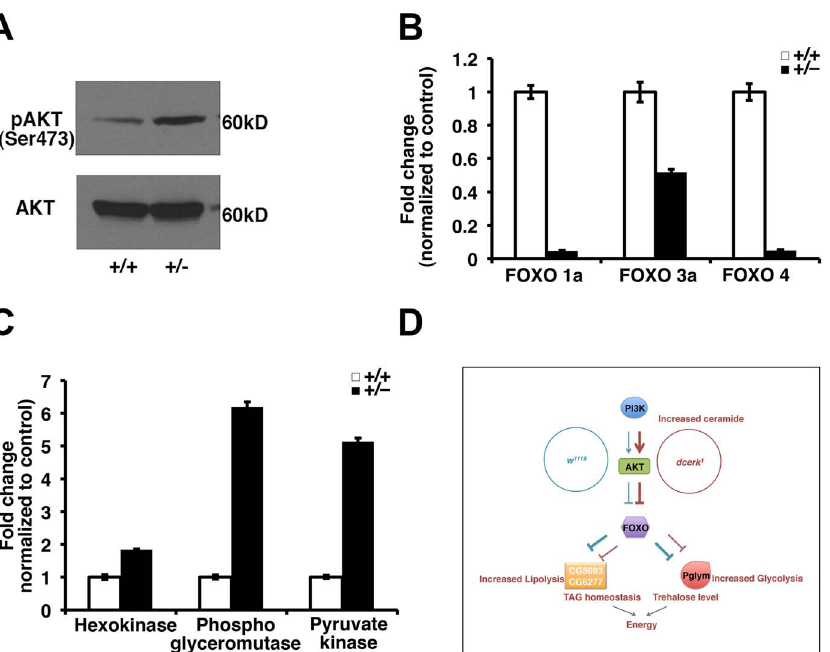
Figure 7. Activation of AKT, decrease in FOXO and activation of glycolytic genes in CERT heterozygous mice. (A). Total AKT and phosphoAKT levels are monitored in liver extracts from wild type ( + / + ) and CERT heterozygous ( + / 2 ) mice. PhosphoAKT level is increased in CERT heterozygotes while total AKT is not significantly changed. (B). Comparison of different FOXO in liver tissue of wild type ( + / + ) and CERT heterozygous ( + / 2 ) mice shows significant decrease in their transcript levels. (C). Comparison of glycolytic genes in skeletal muscle from wild type ( + / + ) and CERT heterozygous ( + / 2 ) mice shows greater than 5 fold increase in transcript levels of phosphoglycerate mutase and pyruvate kinase and 1.8 fold increase in hexokinase. (D). A simple graphical model depicting metabolic reprogramming in dcerk 1 due to increased AKT activation and decreased FOXO to maintain energy balance. dcerk 1 mutants show glucose utilization through increased glycolytic flux mediated by Pglym and downstream enzymes. They also show increased utilization of triglycerides mediated by CG8093 and CG6277.